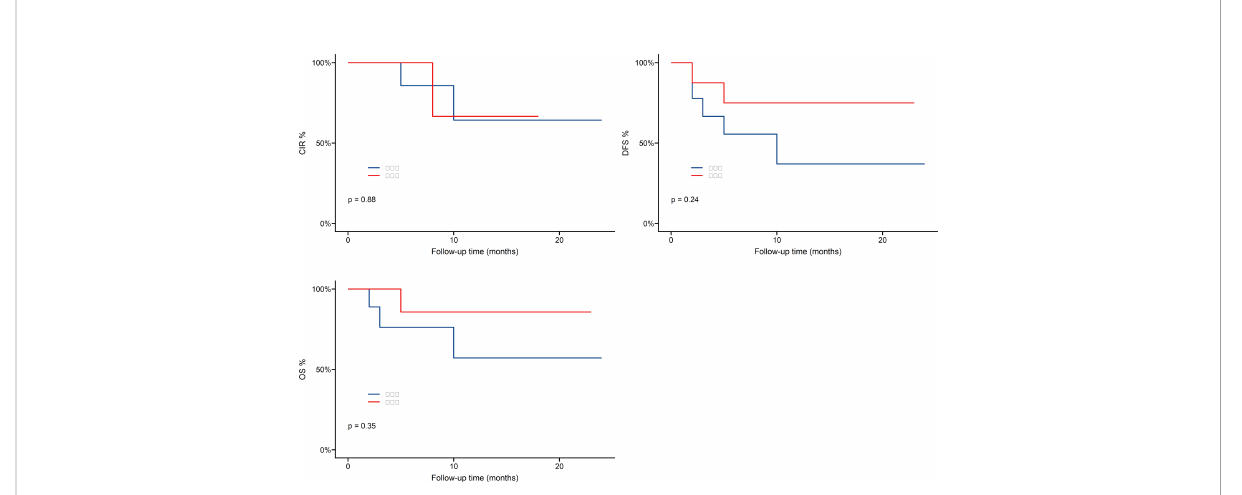
FIGURE 5 Survival outcomes of Haploidentical versus HLA-matched